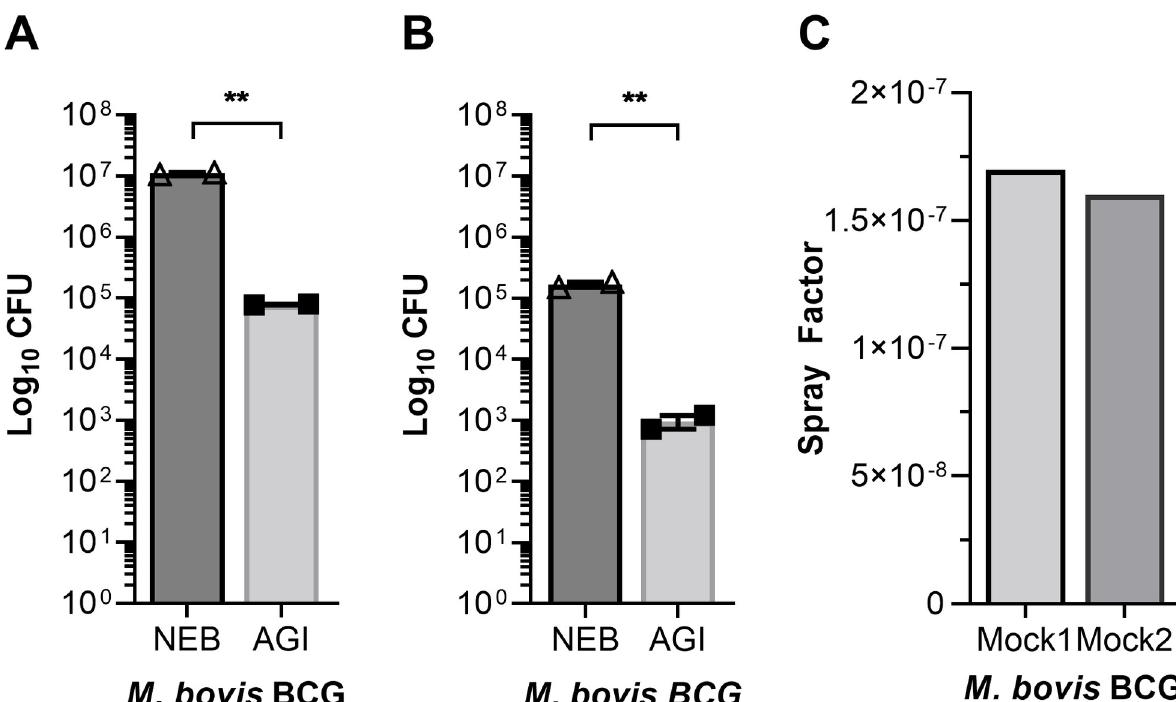
Fig 3. Bacterial burden in aerosol assembly during mock experiment. Bacterial burdens obtained in nebulizer (NEB) and biosampler (AGI) plotted as total CFUs; mock1 (A), mock2 (B). Spray factor for each mock1 and mock2 aerosol procedures (C). Data are mean ± SEM, unpaired t- Test, �� P = 0.0016 for mock1, �� P = 0.0090 for mock2 using Graphpad prism